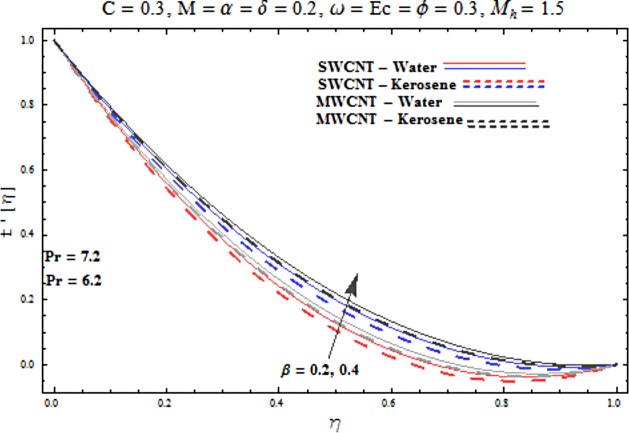
Effect of β on f′.